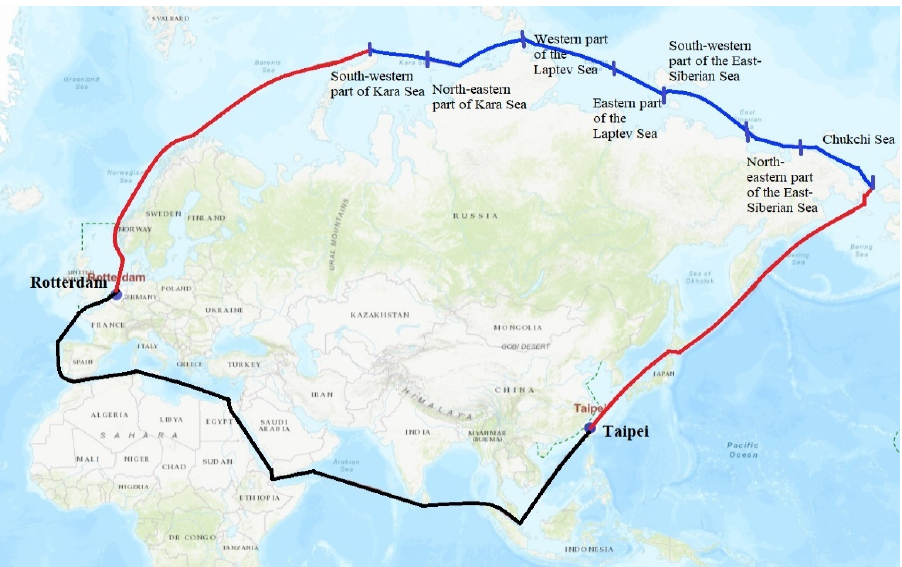
Figure 3. Routes along the Europe sea route (black) and Northeast Passage (red and blue). The Russian government zoned the Northeast Passage into seven areas (blue), which from east to west are the Chukchi Sea, North-eastern part of the East-Siberian Sea, South-western part of the East-Siberian Sea, Eastern part of the Laptev Sea, Western part of the Laptev Sea, North-eastern part of the Kara Sea, and South-western part of the Kara